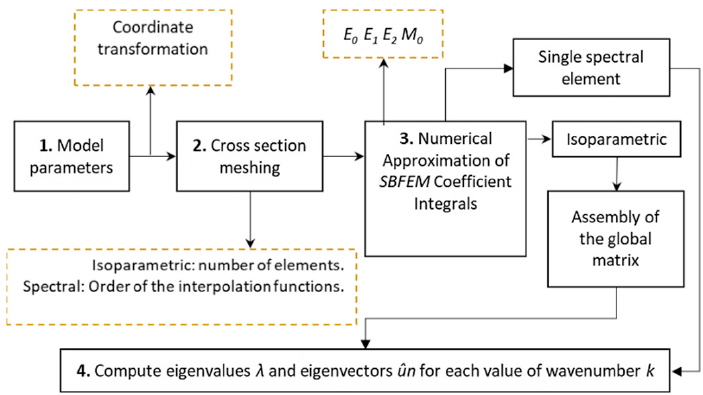
Figure 3. Schematic diagram of the proposed algorithm for plotting dispersion curves by SBFEM. The second step is the meshing of the plate cross-section. So, the number of isopara- metric elements and the order of the shape functions in the case of spectral elements are